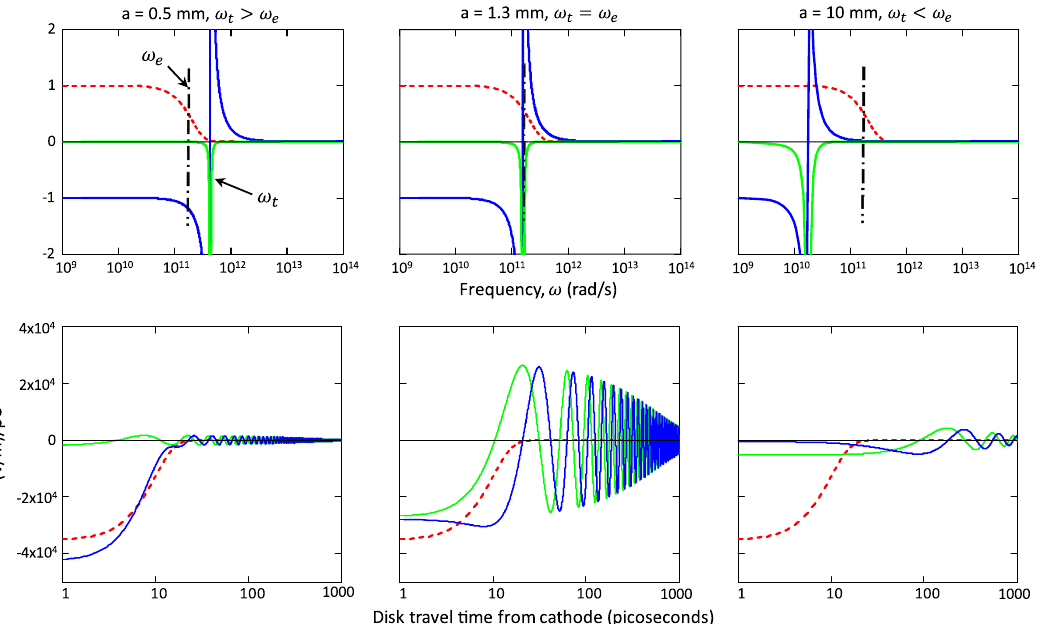
FIG. 11. The frequency spectra and the image-charge fields vs the time for three wire array metamaterials with spacings of a ¼ 0 . 5 , ≅ ω > ω < ω 1.3, and 10 mm corresponding to ω , ω , and ω , respectively. The other array characteristics are given in Table II. The t e t e t e image field and its frequency spectrum for q 0 ¼ − q are plotted with red dashed lines for reference and comparison. The applied field is not shown. Upper plots: The image-charge field frequency spectrum normalized at ω ¼ 0 and the real and imaginary parts of the surface ¼ 1 . 7 × 10 11 rad = s. Red dashed curve: 1 loss function. The vertical dash-dotted line is the edge frequency at ω e ð ω Þ . Green solid curve: − Im g ð ω Þ . Lower plots: The image-charge field per pC at the disk center. Blue solid curve: curve: − Re g c c ð t Þ ; green solid curve: Im E Gaussian ð t Þ ; red dashed curve: E ð t Þ with q 0 ¼ − q Re E Gaussian image image image